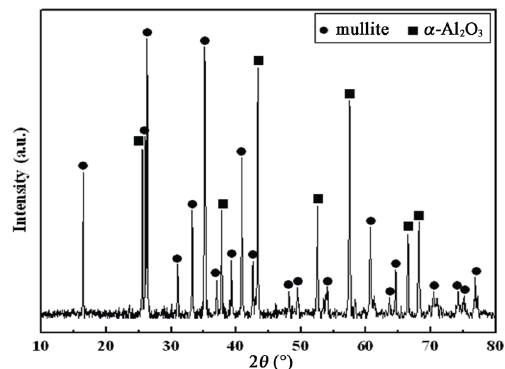
Fig. 5 XRD patterns of Al 2 O 3 –SiO 2 gel powders after heat treatment at 1600 ℃ .